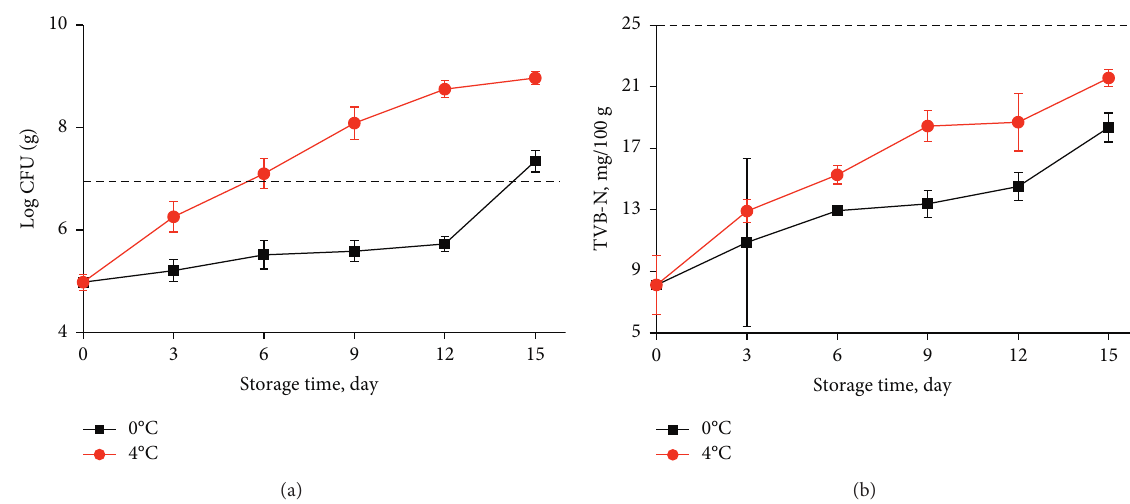
Figure 1: Changes in bacterial counts and TVB-N content of rainbow trout fillets during storage at 0 ° C and 4 ° C. (a) Total bacterial colonies. The dashed line represents the maximum bacterial limit for fish (7.0 log CFU/g) according to the International Commission of Mi- crobiological Standards for Foods (ICMSF). (b) TVB-N content. The dashed line represents the maximum TVB-N limit for fresh fish (25mg/100g) according to European Union (EC no.